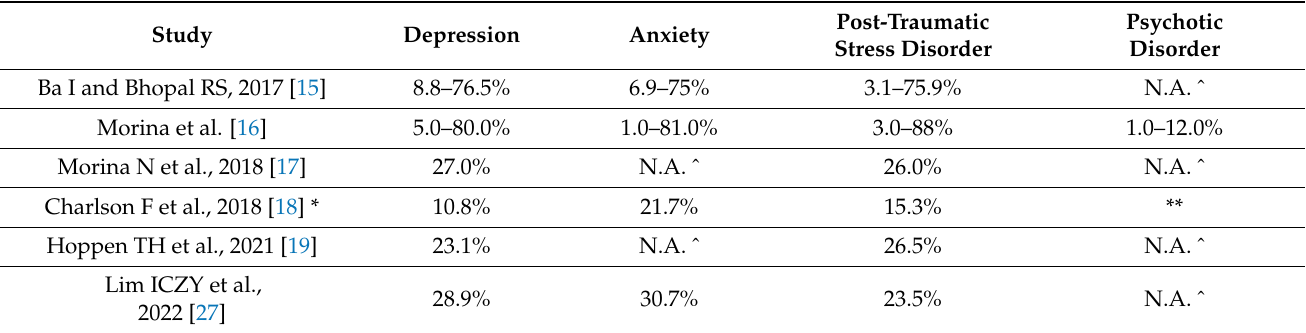
Table 3. Prevalence rates of mental disorders in systematic reviews/meta-analyses conducted on samples of refugees/people living in war/conflict-affected